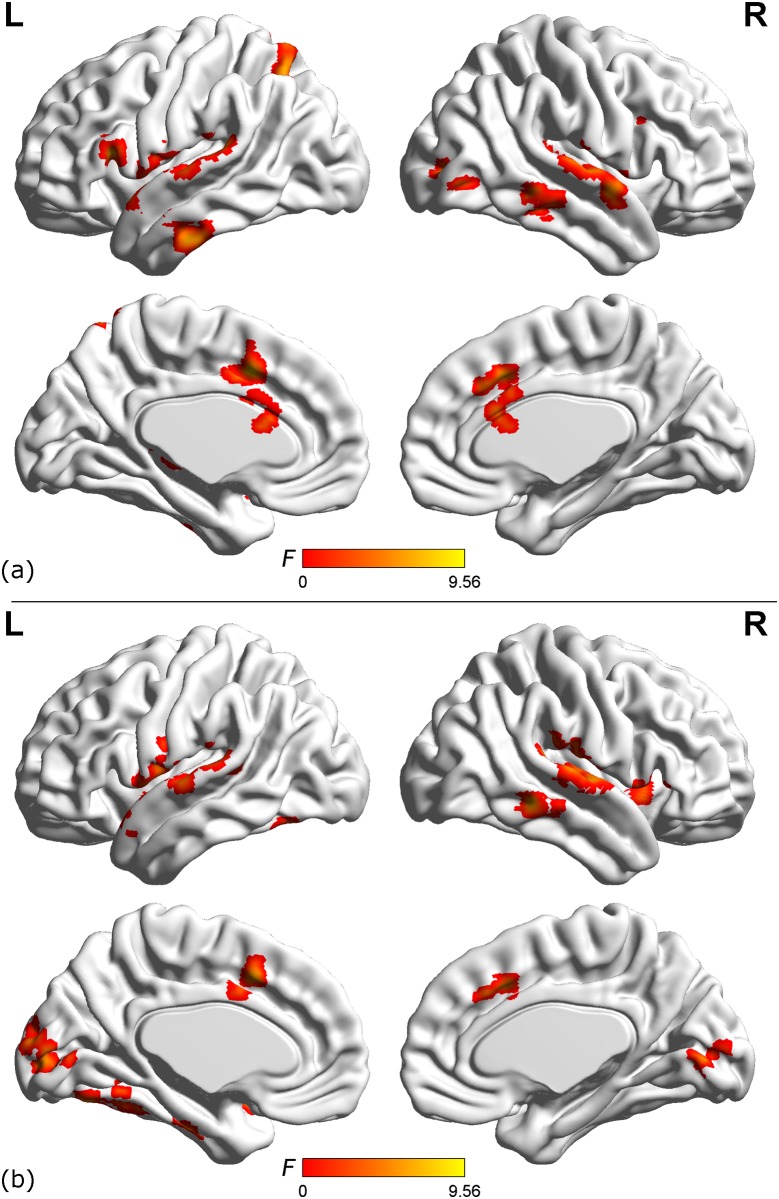
Brain areas with significant differences in the functional connectivity to the left thalamus (a) and right thalamus (b) among LMCI patients, EMCI patients and healthy control group (P < 0.01, 40 voxels, Alphasim corrected).